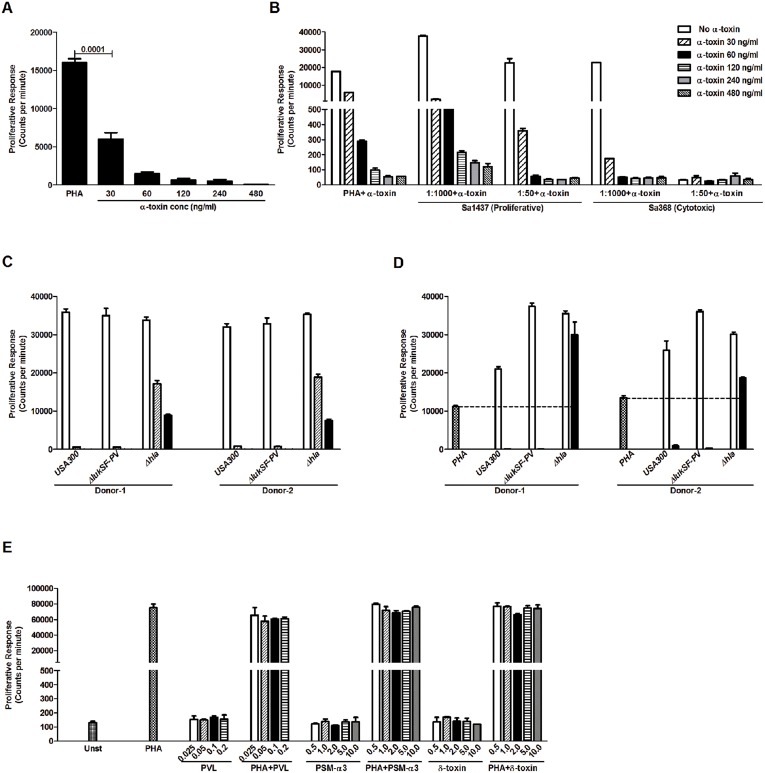
Alpha-toxin mediates cytotoxicity in PBMC.A) Proliferation assay using human PBMC stimulated with PHA alone or in the presence of different concentrations of α-toxin. Proliferative responses were determined by 3H-thymidine uptake and are presented as mean counts per minute ± SD. Mean values of four different experiments from different donors are shown. B) Inhibition of PHA-induced and bacterial supernatant-induced proliferation of PBMCs by addition of increasing concentrations of α-toxin (60 to 480 ng/ml). The figure shows one representative of two experiments using cells from different donors. C) Proliferation assay using cells from two donors stimulated with different dilutions (1∶1000 (open), 1∶100 (stripped) and 1∶50 (filled) bars) of supernatants prepared from USA300 (LUG2012), and its isogenic mutants of PVL (ΔlukSF-PV) and α-toxin (Δhla). D) Proliferative responses assessed in cells stimulated with PHA alone or in combination with indicated supernatants at dilutions 1∶1000 (open) and 1∶50 (filled) bars. The figure shows experiments using cells from two donors. E) PBMC were stimulated with increasing concentrations of PVL, PSM α3 and δ-toxin at indicated concentrations (µg/ml) alone and in combination with PHA. Statistical significant differences were determined by Fisher's exact test with two sided p value and p value is indicated in the figure.